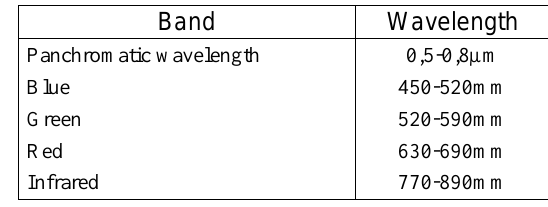
Table 4. ZY3 spectral bands wavelength